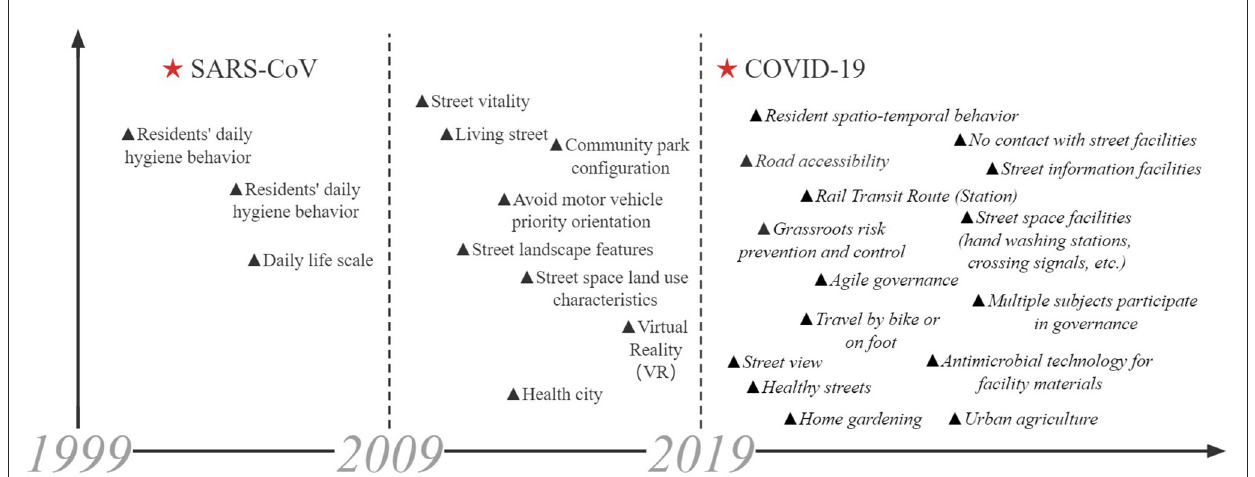
FIGURE12 Trend of theme change by